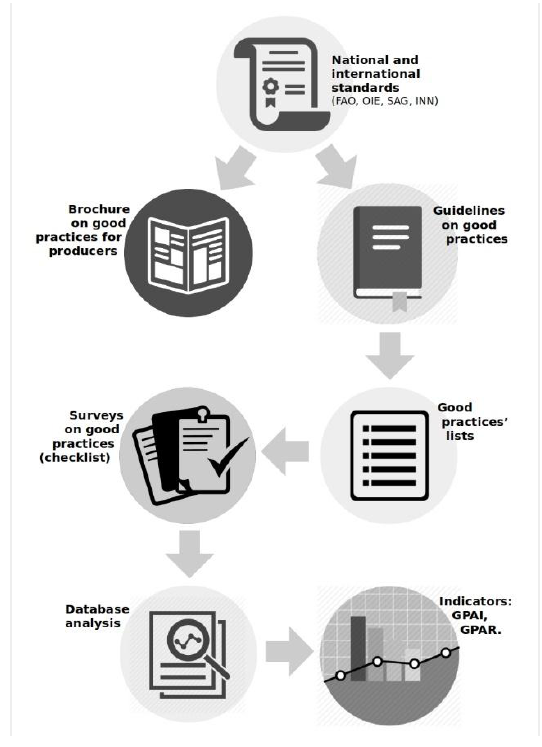
Figure 1. Origin and outcomes of good practice measures and training material.